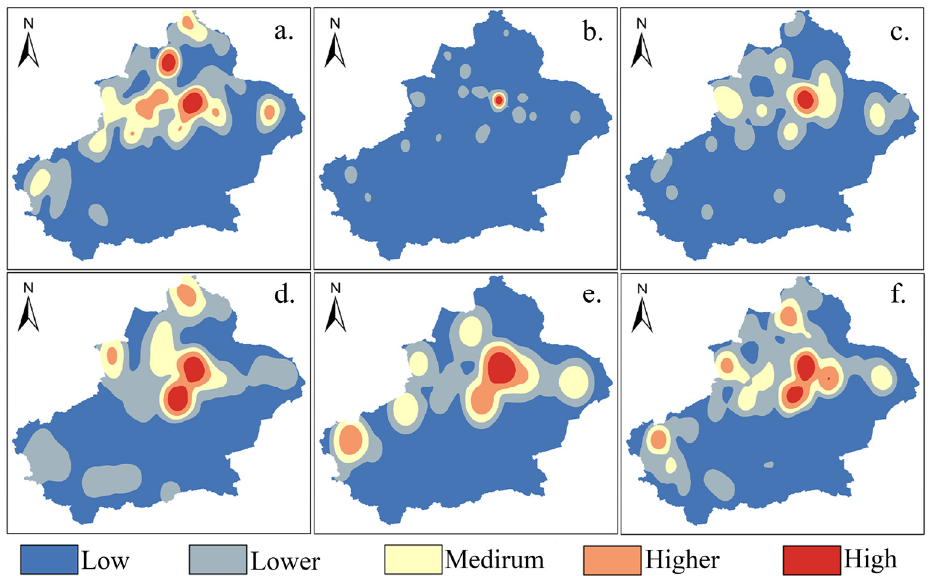
Figure 3. Kernel densities of different tourism resource categories in Xinjiang. ( a ) Geological land- scape; ( b ) architectural landscape; ( c ) biological landscape; ( d ) water landscape; ( e ) entertainment and shopping; ( f ) site ruins.